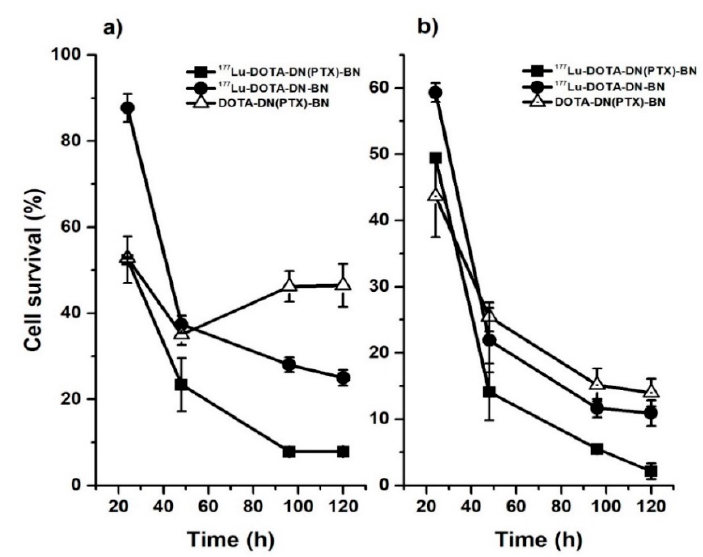
Figure 7. In vitro therapeutic efficacy of 177 Lu-DOTA-DN-(PTX)-BN on T47D cell line, ( a ) cell survival fraction resulted from 16.1 MBq per cell and the equimolar concentration of the unlabeled nanosystem, ( b ) cell survival fraction resulted from 32.2 MBq per cell and the equimolar level of the unlabeled nanosystem.